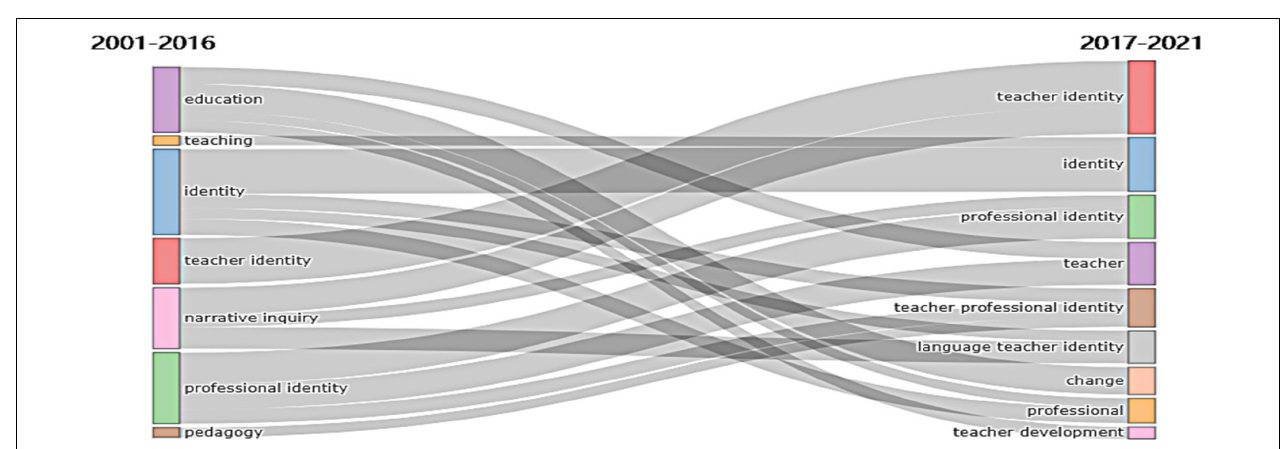
FIGURE 11 | Thematic Evolution by author’s